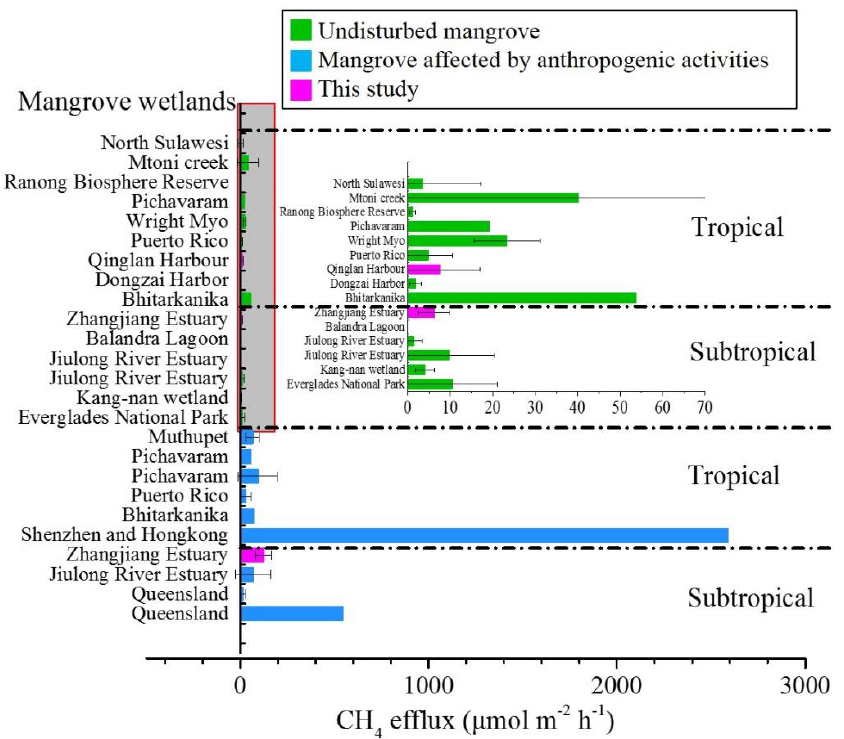
Figure 3. Comparison of CH 4 efflux from undisturbed mangrove wetlands and mangroves wetlands affected by anthropogenic activities. Detailed information on the literature sources of CH 4 efflux data is provided in Table S2. Nutrient concentrations and assignment of eutrophic status from mangrove wetlands are shown in Table S3.